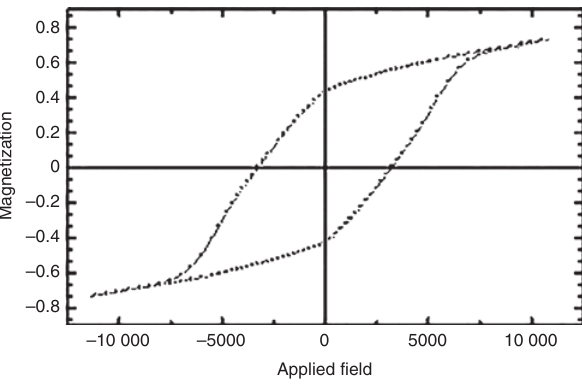
Figure 16: Magnetization loop of PC-SrFe